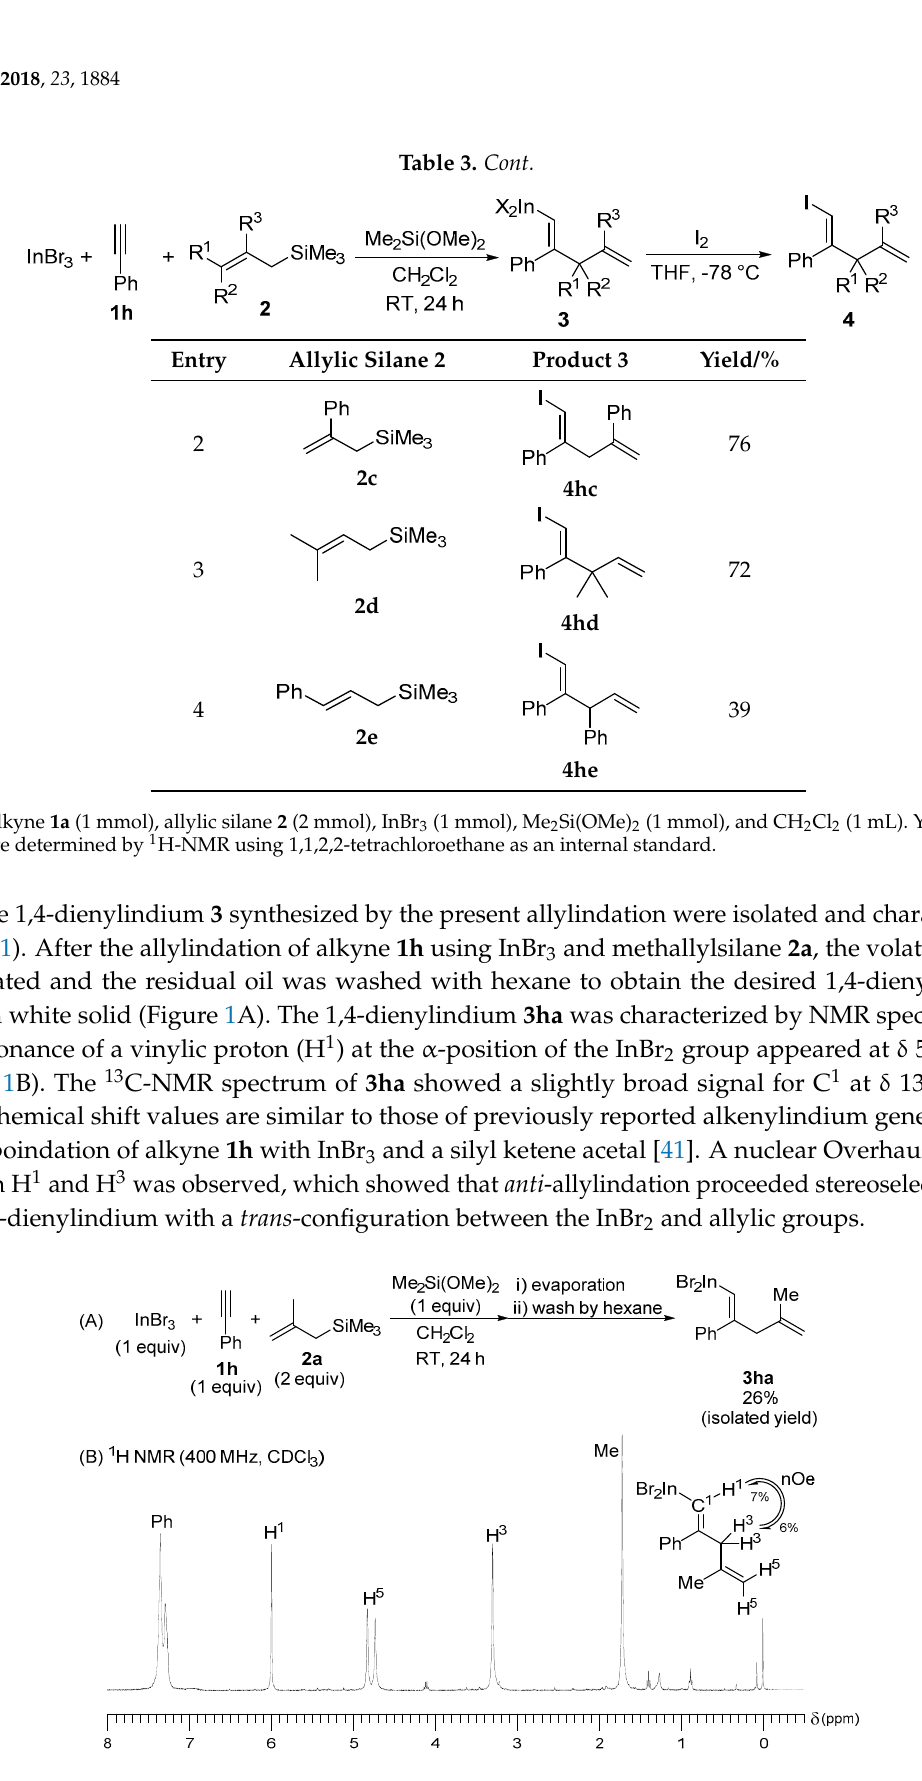
Table 3. Scope of allylic silane 2 in allylindation a .